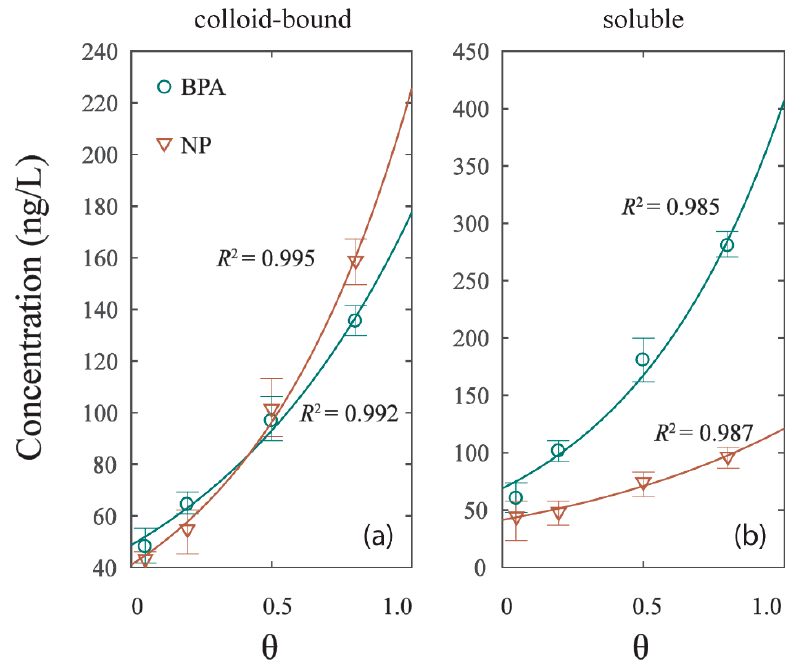
Figure 4. The correlation of EDCs concentration in different phases and hydrodynamic intensity ( θ ). ( a ) Colloid-bound phase. ( b ) Soluble phase. Table 3. Coefficients of nonlinear fitting of hydrodynamic intensity and EDCs content. Phases EDCs k 1 k 2 R 2 BPA 48.73 colloid-bound NP